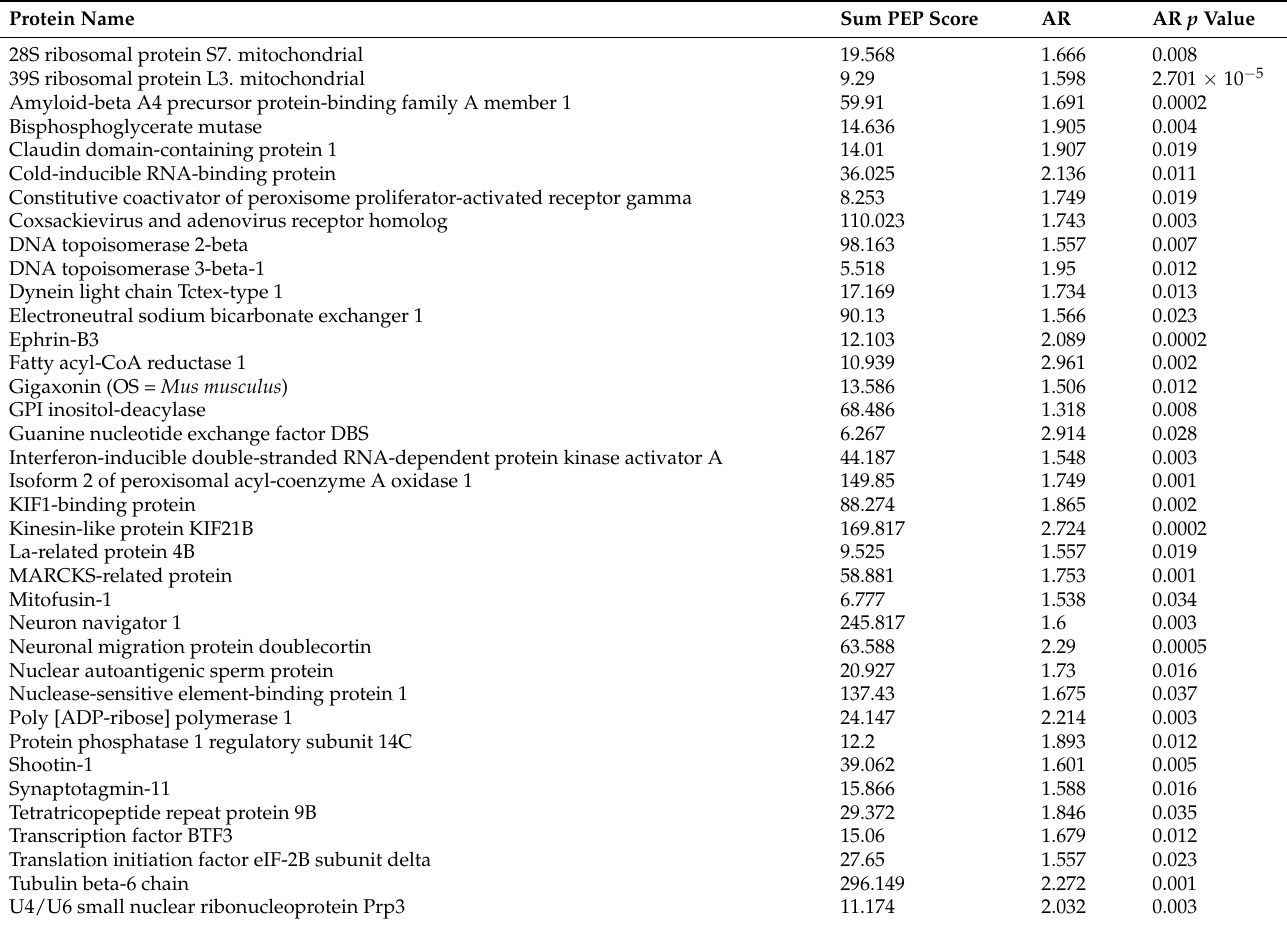
Table 1. Upregulation of proteins associated with the overexpressed pathways in hyh mice 14 days after BM-MSC treatment at P4. Sum PEP score corresponds to the score calculated based on the posterior error probability (PEP) values of the peptide spectrum matches (PSM). Sum PEP score indicates the probability that an observed PSM is incorrect. Abundance ratio (AR) indicates the relation of the protein expression in BM-MSC-transplanted mice/sham-injected hyh